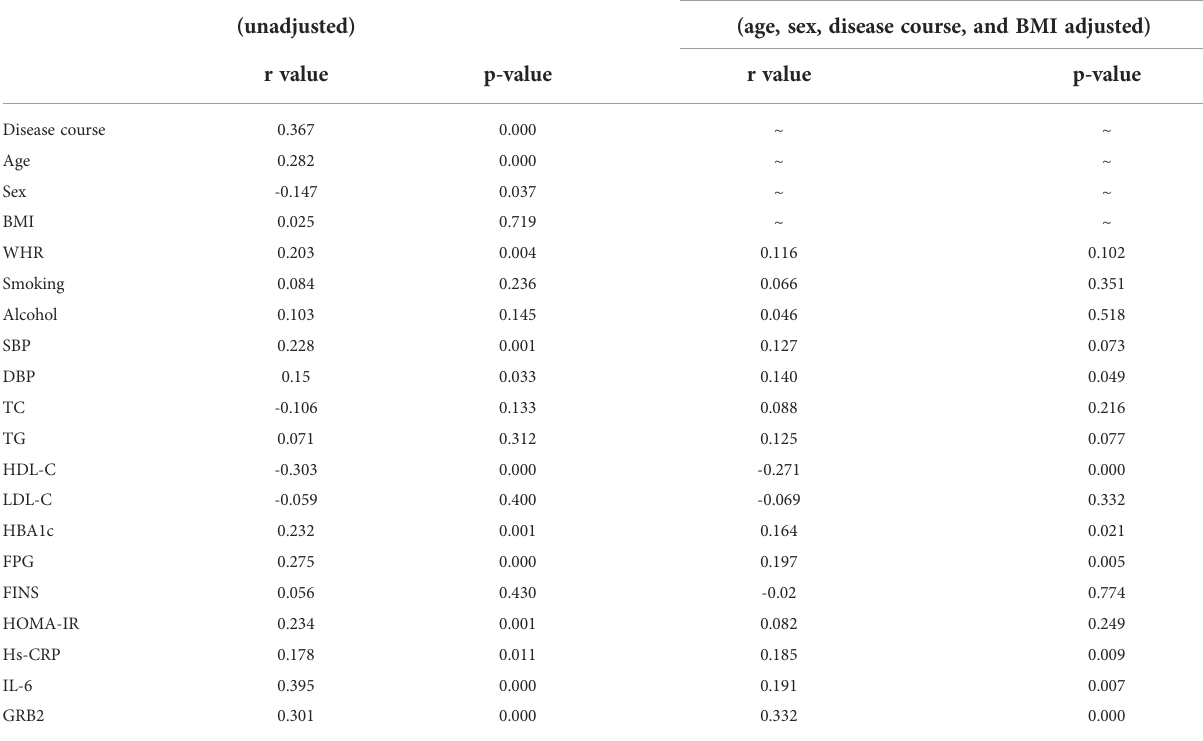
TABLE 5 Correlation analysis of variables associated with CIMT in the study population.